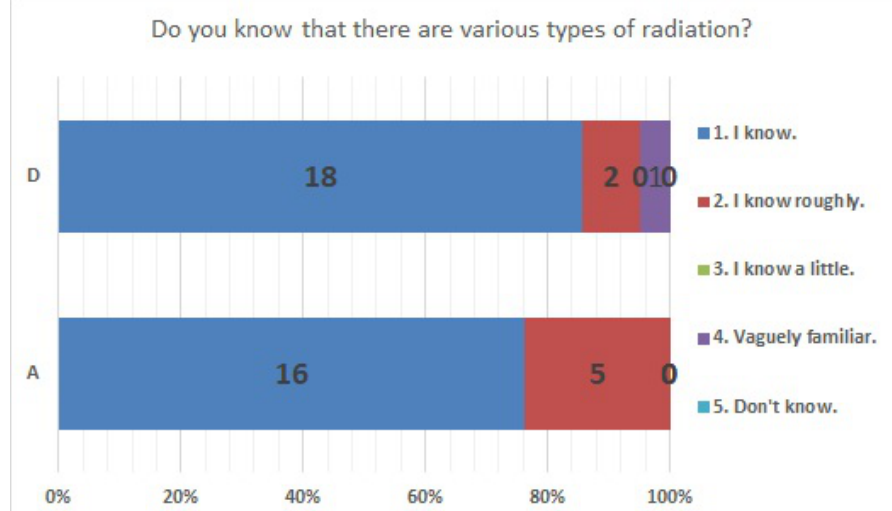
Figure 9. Responses to item No.